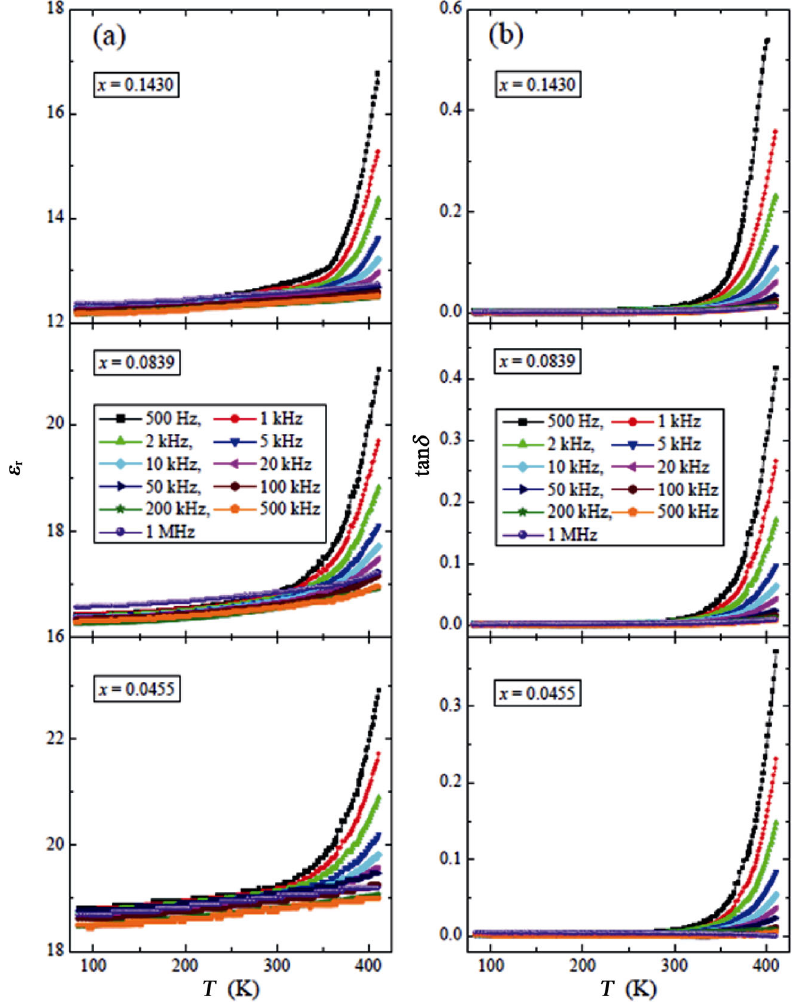
Fig. 8 Relative permittivity  r (a) and loss tangent tan  (b) vs. temperature T within the frequency range of 500 Hz–1 MHz of Pb 1–3 x (cid:0) x Gd 2 x (MoO 4 ) 1–3 x (WO 4 ) 3 x materials for x = 0.0455, 0.0839,